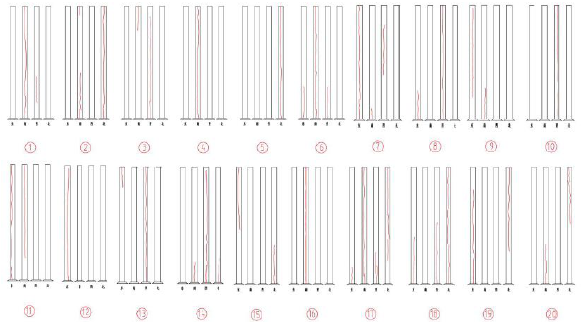
Figure 6. Four square pillar surface